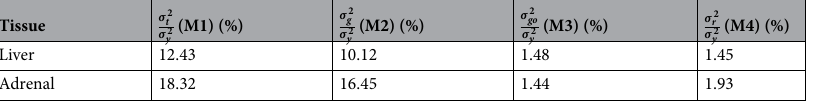
σ 2 σ 2 g the gene variance, go the GO term variance,